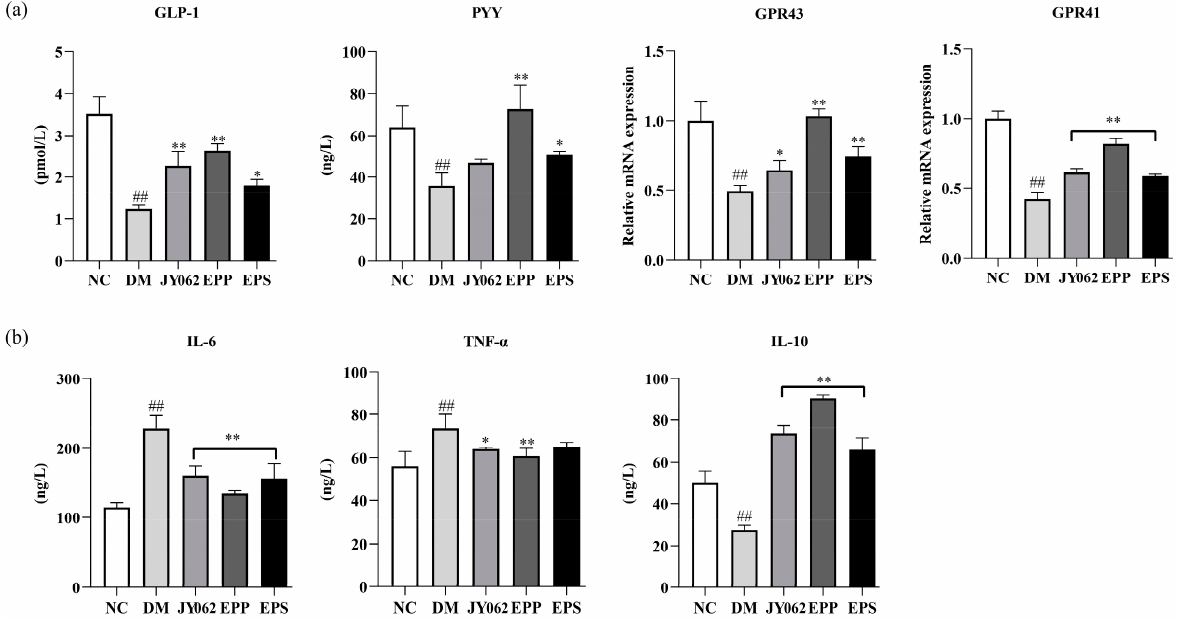
Figure 8. Effects of dietary intervention on gastrointestinal hormones and inflammatory factors. ( a ) The contents of GLP-1 and PYY in serum (determined by Elisa kits) and the mRNA expression of GPR41/43 in colon tissue (determined by RT-PCR); ( b ) the contents of TNF- α , IL-6 and IL-10 in serum (determined by ELISA kits). Data are presented as mean ± SD values. ## p < 0.01 vs. NC group; * p < 0.05, ** p < 0.01 vs. DM group.